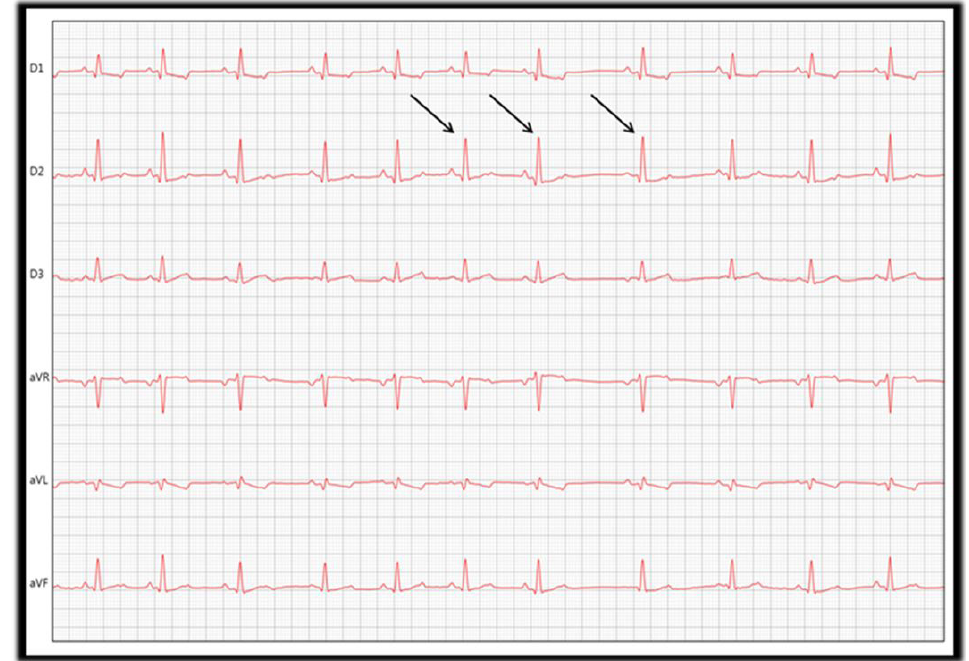
Figure 12. Electrocardiographic tracing at a speed of 50mm/s, showing tracing on bipolar leads, showing sinus arrhythmia, represented by irregular R-R intervals (arrows), not exceeding 50% of the anterior interval. (Source: Personal Archive).